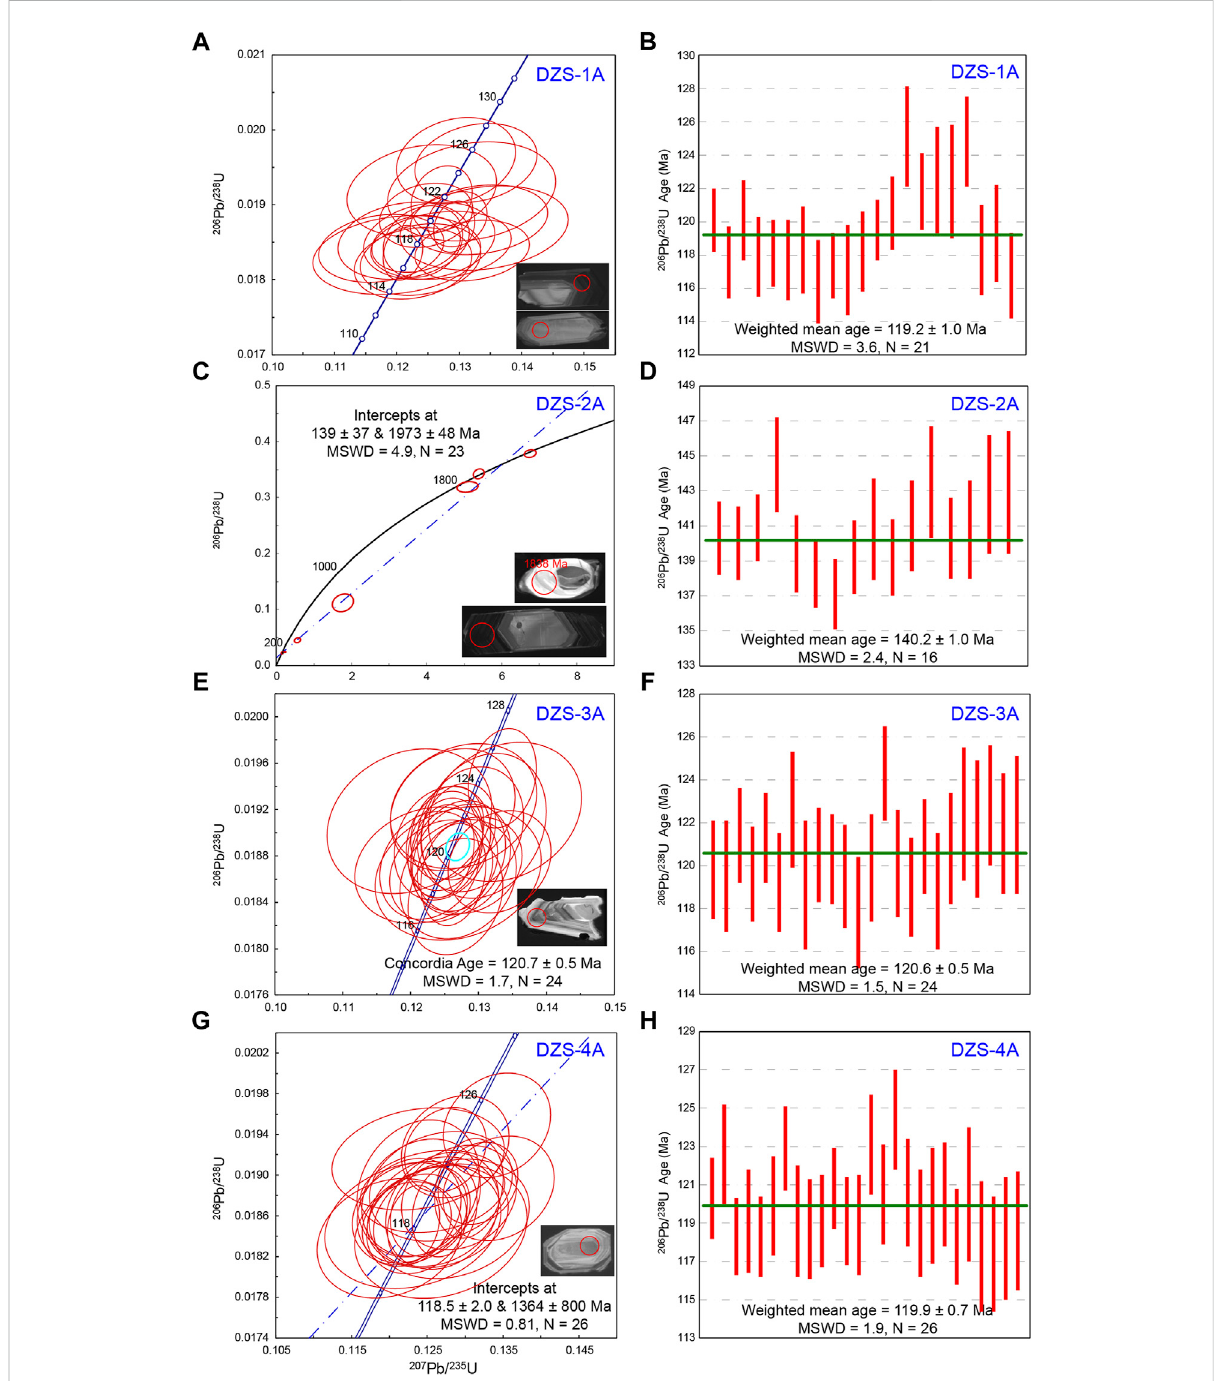
FIGURE 7 Zircon U-Pb concordia and weighted mean 238 U/ 206 Pb ages of the studied magmatic rocks. The red circles in the zircon grains are analytical spots and are 30 μ m in diameter. (A,B) Quartz porphyry; (C,D) Linglong granite; (E,F) rhyolite porphyry; (G,H) Dazeshan biotite granite.